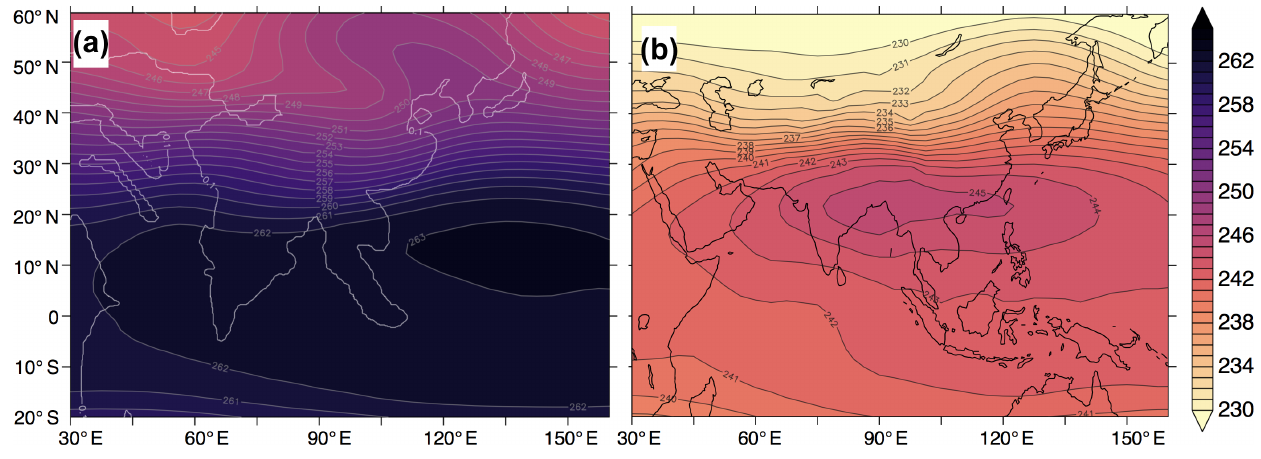
Figure 8. JJA Air Temperature (in kelvin) at 300mbar for EOC4X (a) and control (b) with contours overlaid each